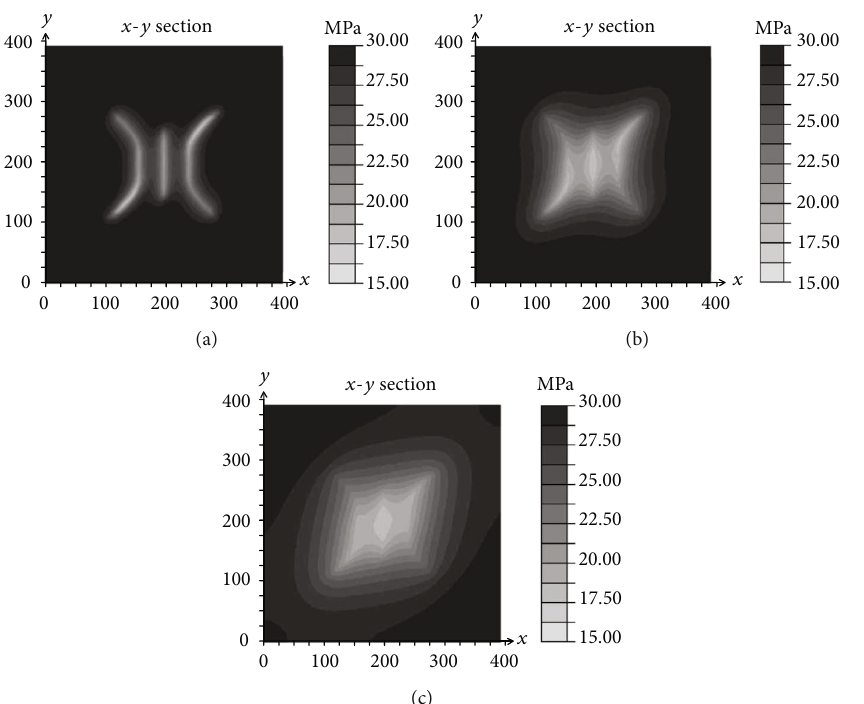
Figure 16: (a), (b), and (c) present the pore pressure distribution after 1, 5, and 10 years of nonplanar fracture production considering the in fl uence of natural